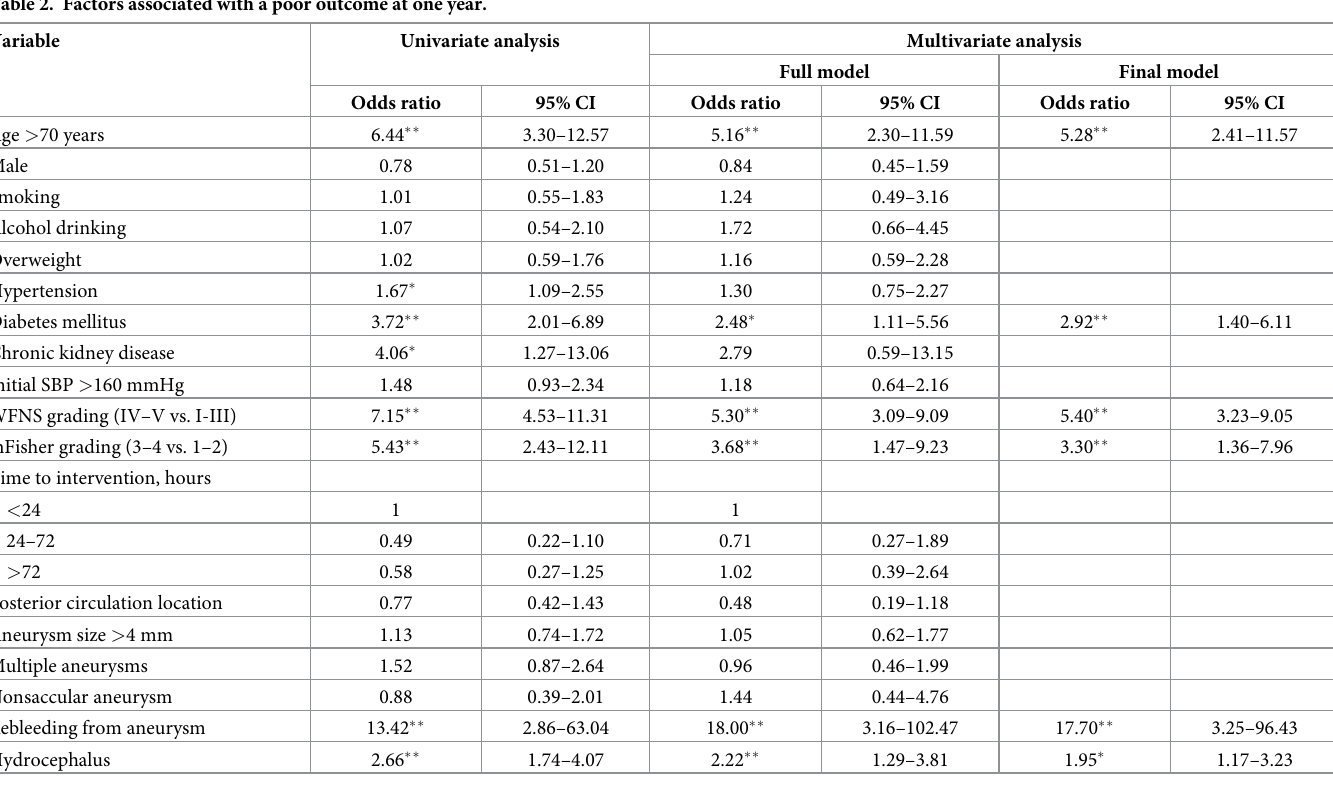
Table 2. Factors associated with a poor outcome at one year.